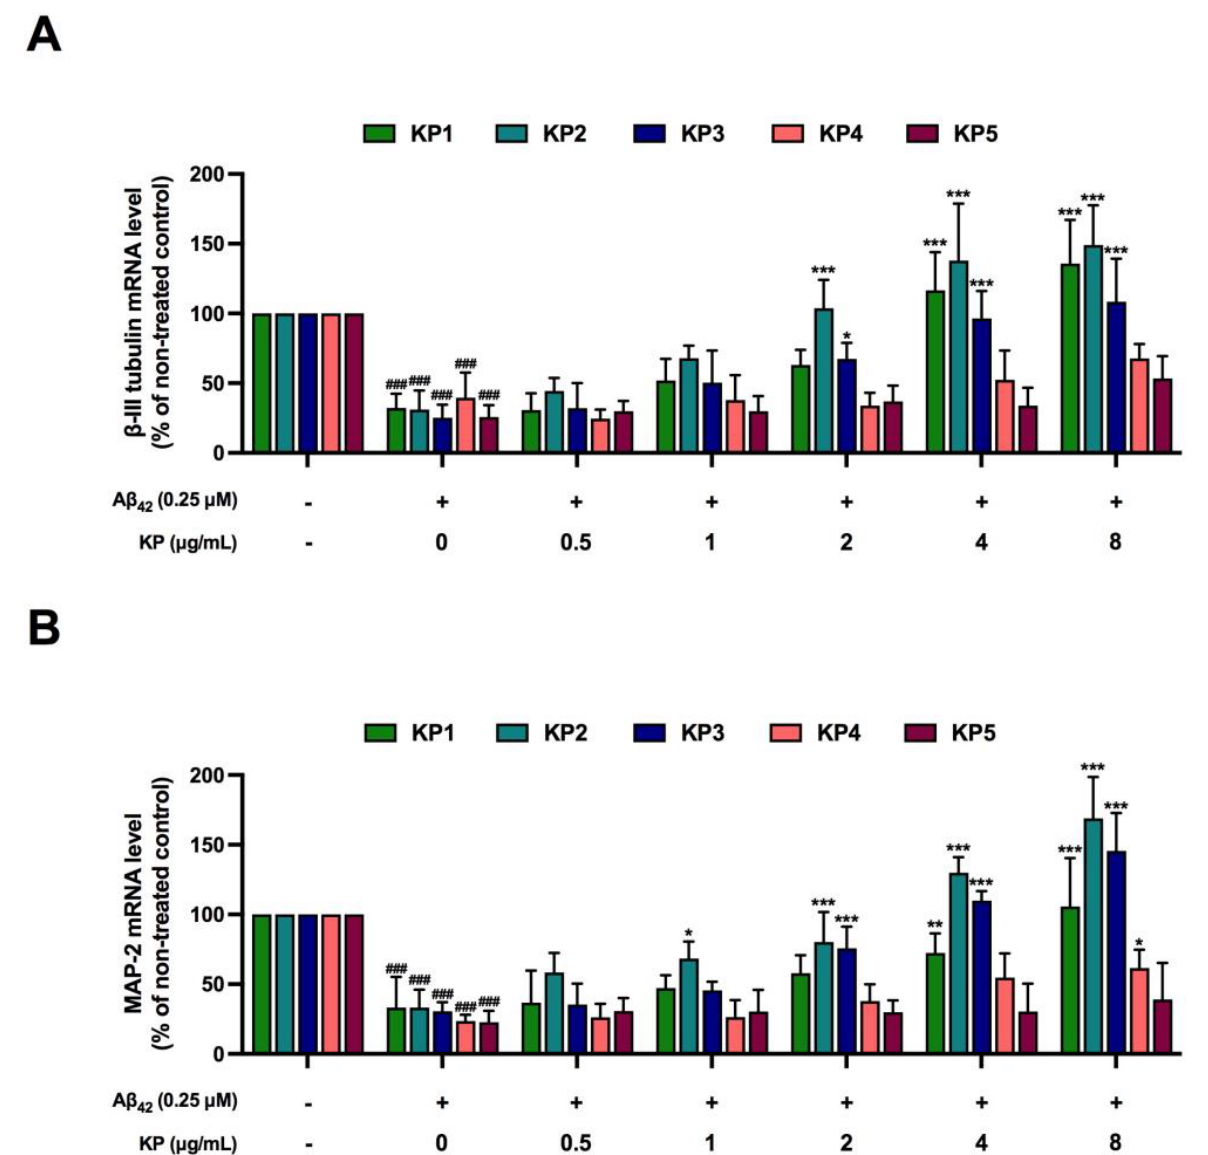
Figure 7. The protective effects of K. parviflora against neurogenesis-inhibiting A β 42 peptides in monoculture of differentiated NE-4C cells. ( A ) beta-III tubulin mRNA levels and ( B ) MAP-2 mRNA levels. The ### shows a significantly different between control and cells exposed to A β 42 peptides with- out KP extract at p < 0.001 using one-way ANOVA followed by Tukey’s test. The * shows a signifi-